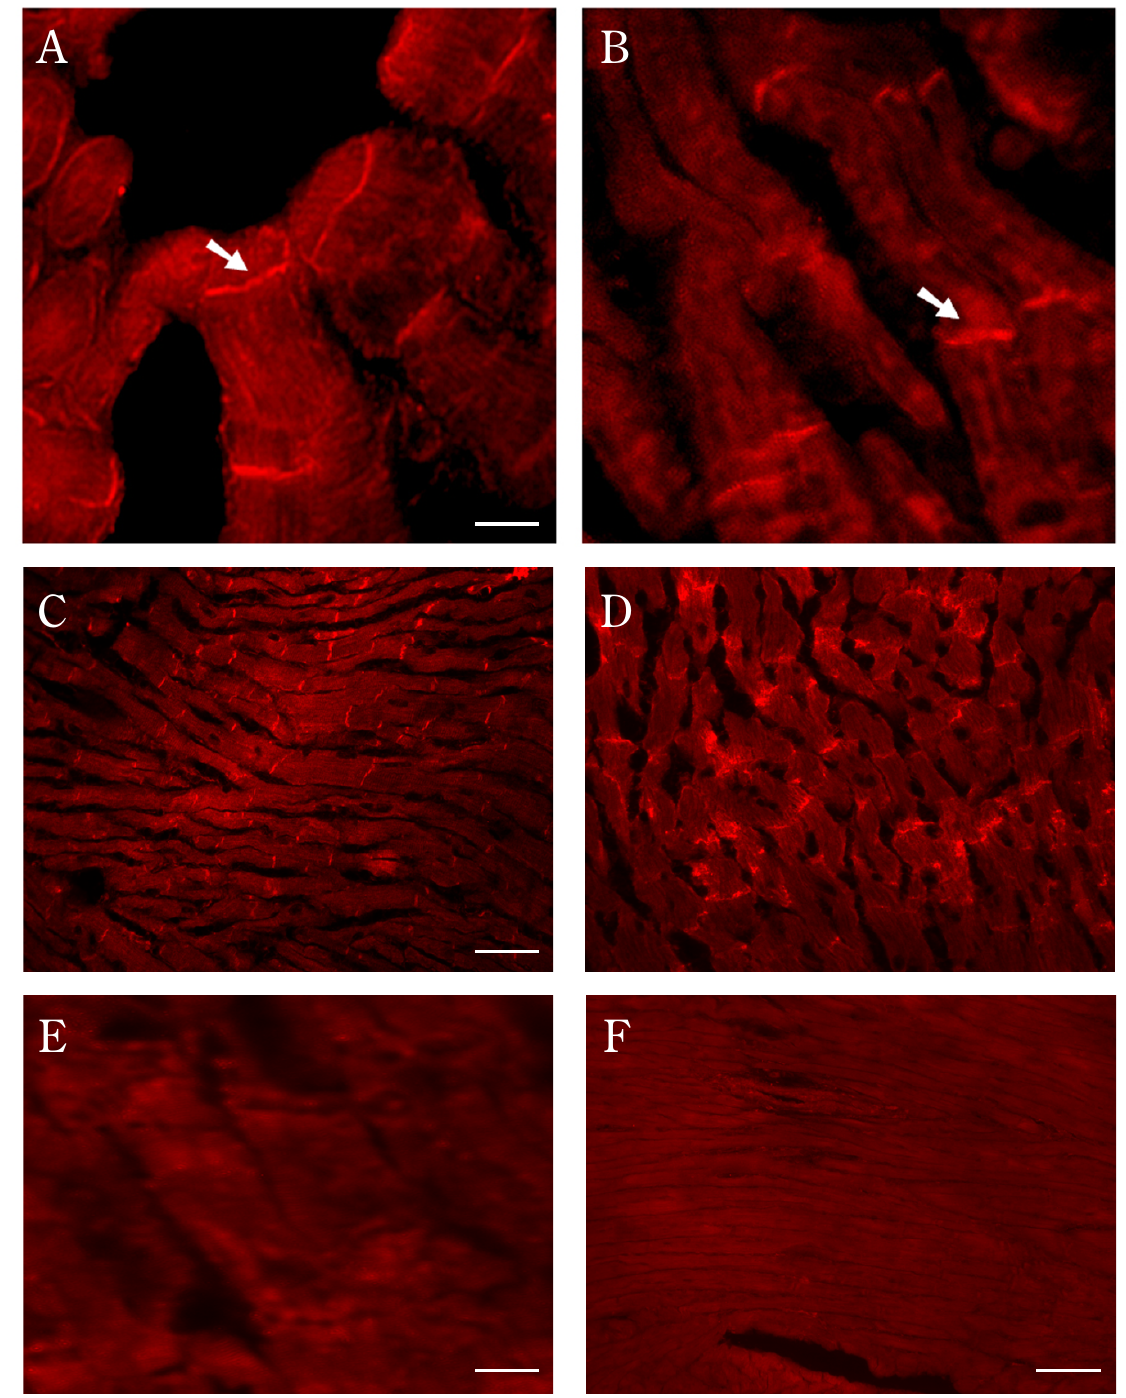
Figure 4 Immunolocalization of CAR to intercalated discs in human and murine cardiac muscle. Human [ A, B ] and murine [ C, D ] cardiac muscle sections were reacted with the polyclonal anti-C-terminal antibodies RP194 [ A, C ] and RP291 [ B, D ]. Note the intense staining of both isoforms at the human intercalated discs (arrow) [ A, B ] and murine intercalated discs [ C, D ]. Neither the human cardiac tissue [ E ] nor the murine cardiac muscle [ F ] gave any signal when incubated with the anti-rabbit IgG. Bar = 10 µ m (A, E); 30 µ m (C,